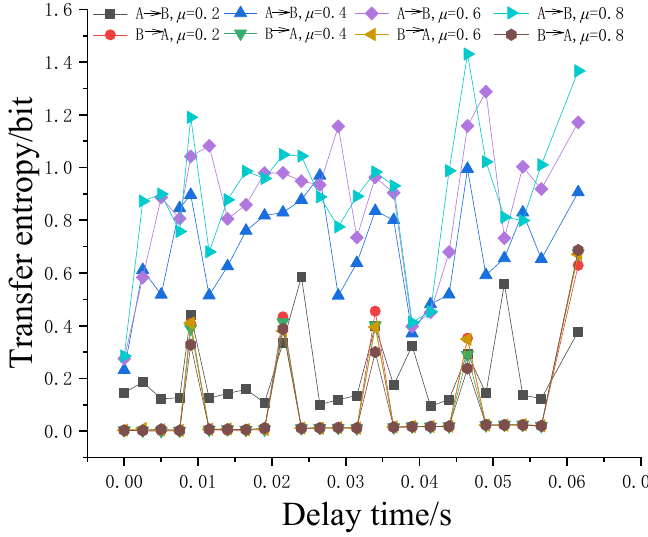
Figure 5. Transfer-entropy curve. Table 2. The information-transmission rate of different correlation coefficients. Correlation Coefficients